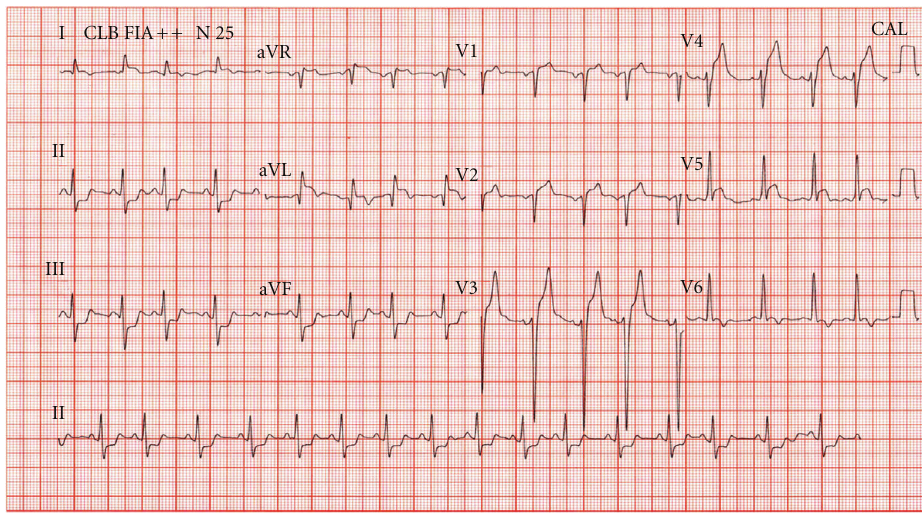
Figure 1: Electrocardiography showing sinus rhythm with ST elevation in leads I, aVL, aVR, V1 to V5 and ST depression in leads DII, DIII, and aVF, compatible with anterolateral wall acute myocardial infarction.